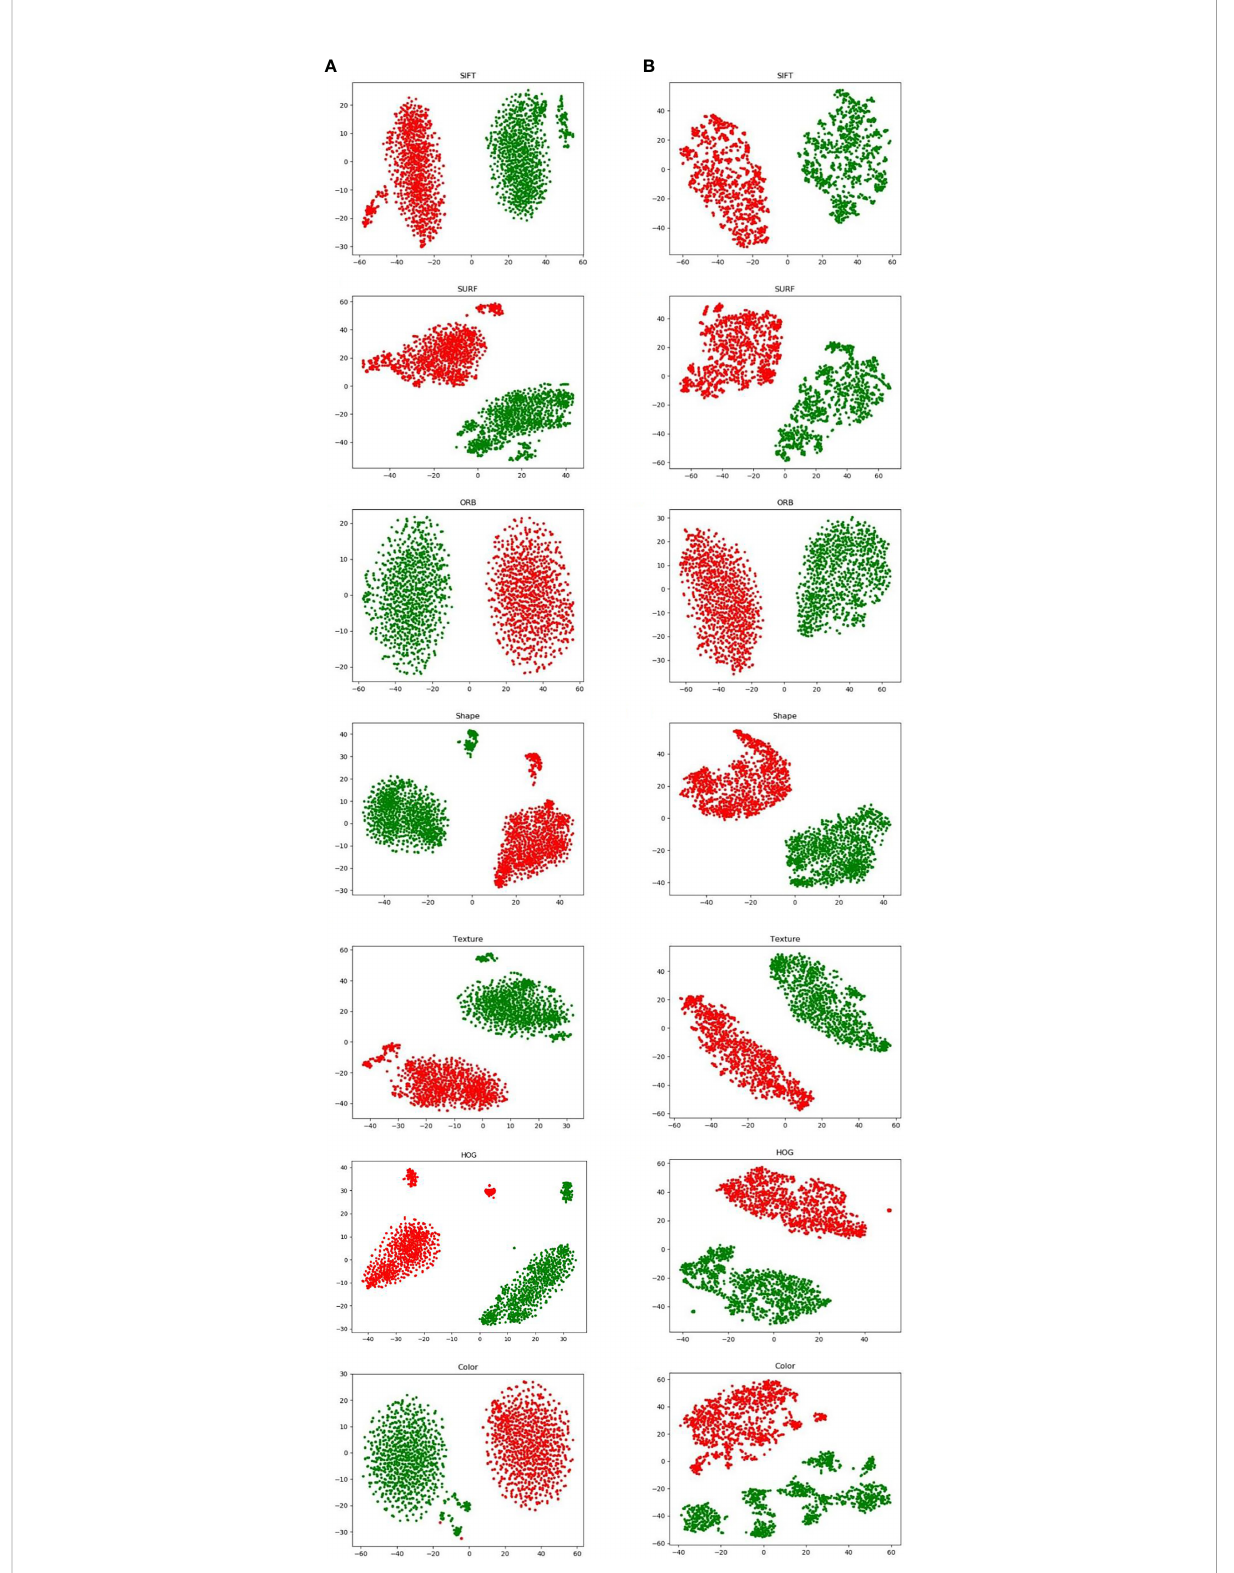
FIGURE 4 Visualization of hand-crafted features using t-SNE from proposed augmentation (A) and image augmentation (B)